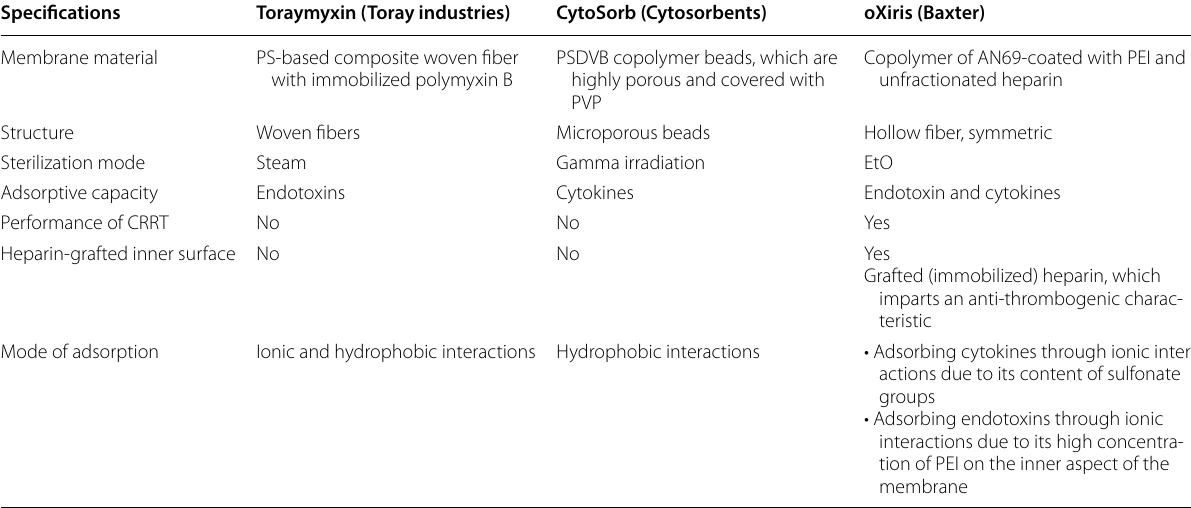
AN69 acrylonitrile and methalylsulfonate, EtO ethylene oxide, PEI polyethylenimine, PSDVB polystyrene divinylbenzene, PS polystyrene, PVP polyvinylpyrrolidone